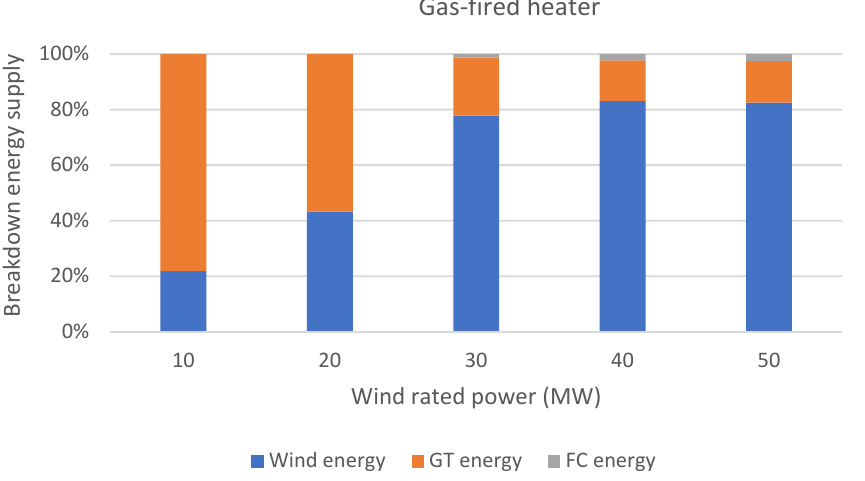
Figure 6. Shares of energy contributions to the overall energy demand for the gas-fired heater configuration–case (b) H/P = 0.32.